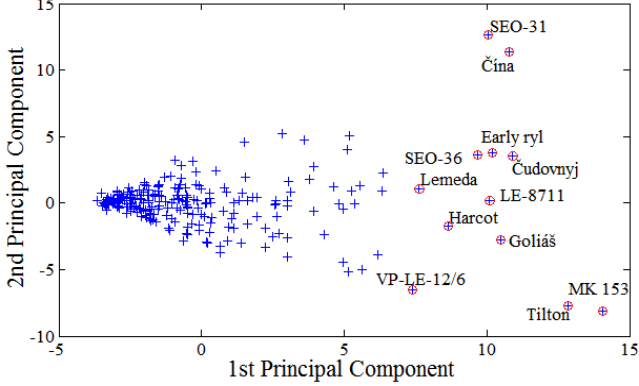
Figure 6. Statistical expression of extreme values of polyhenols content represented by two principal components. The marked apricot cultivars had the extreme values markedly different from the